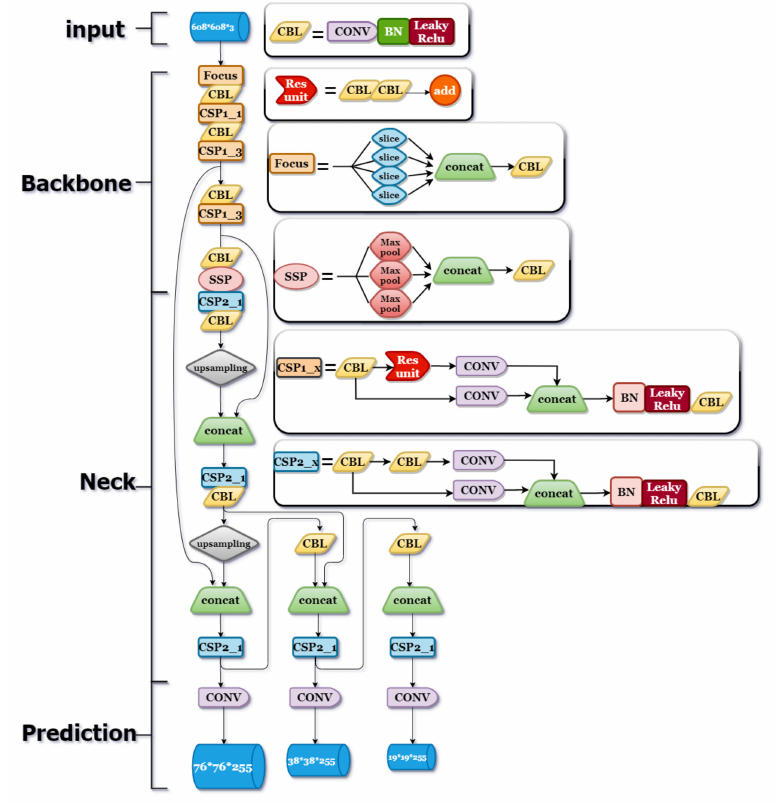
Figure 5. YOLOv5 network structure. The YOLOv5 network includes the input side, backbone side, neck side, and prediction side [25]. The input side is mainly responsible for mosaic data